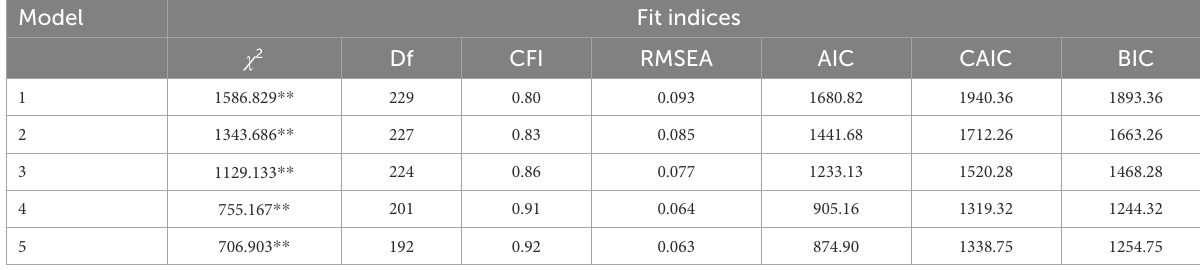
TABLE 6 Confirmatory factor analyses results.